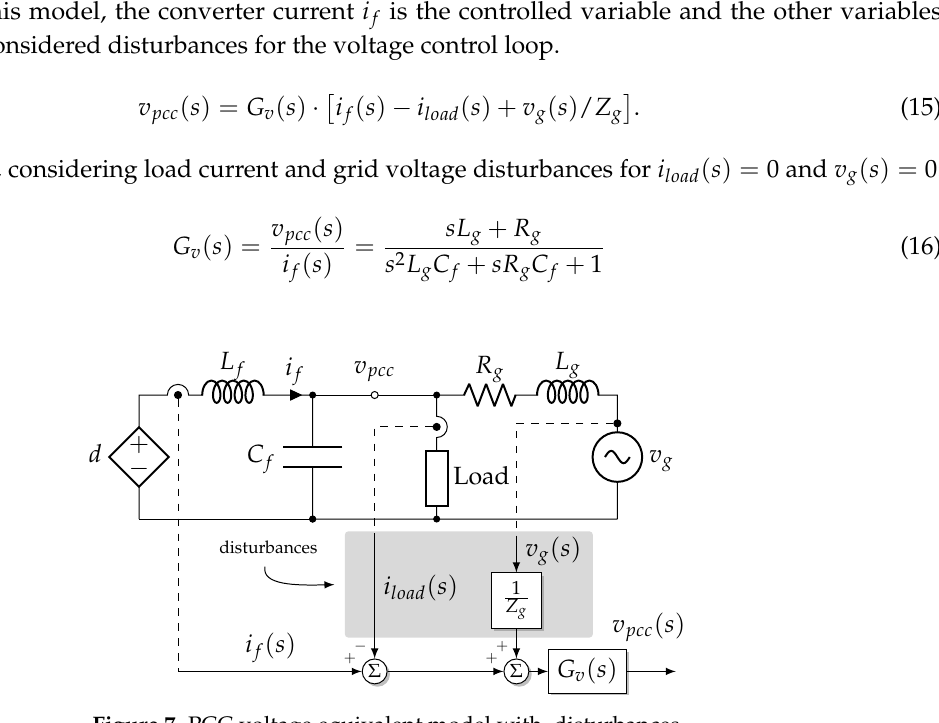
Figure 7. In this model, the converter current i f is the controlled variable and the other variables ( i ) are considered disturbances for the voltage control loop. load , v g